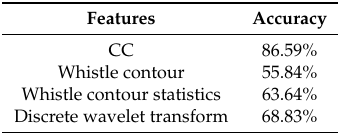
Table 1. Accuracies obtained in the cetacean species classification experiment using four different